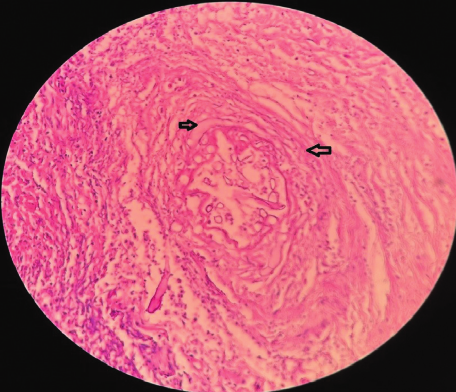
Figure 5: Histopathological examination of tissue sections revealed a vascular structure (large arrow) involved and filled with both thin and broad (smaller arrow) fungal hyphae. (Original magnification ×